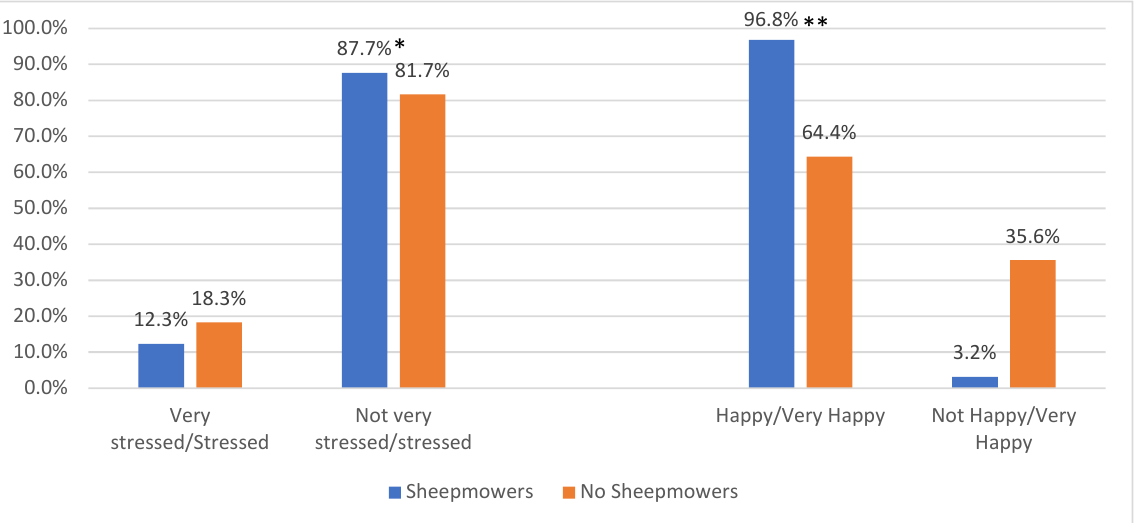
Figure 3. Current Level of Stress at Questionnaire Completion. * Test for differences between Sheepmowers and No Sheepmowers, X 2 (1) = 3.11, p = 0.077. ** Test for difference between Sheepmowers and No Sheepmowers, X 2 (1) = 61.72, p < 0.001. Note: The level of stress responses were collected